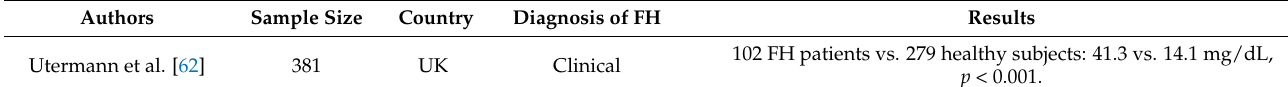
Table 1. Studies investigating prevalence of high Lp(a) levels in patients with FH.